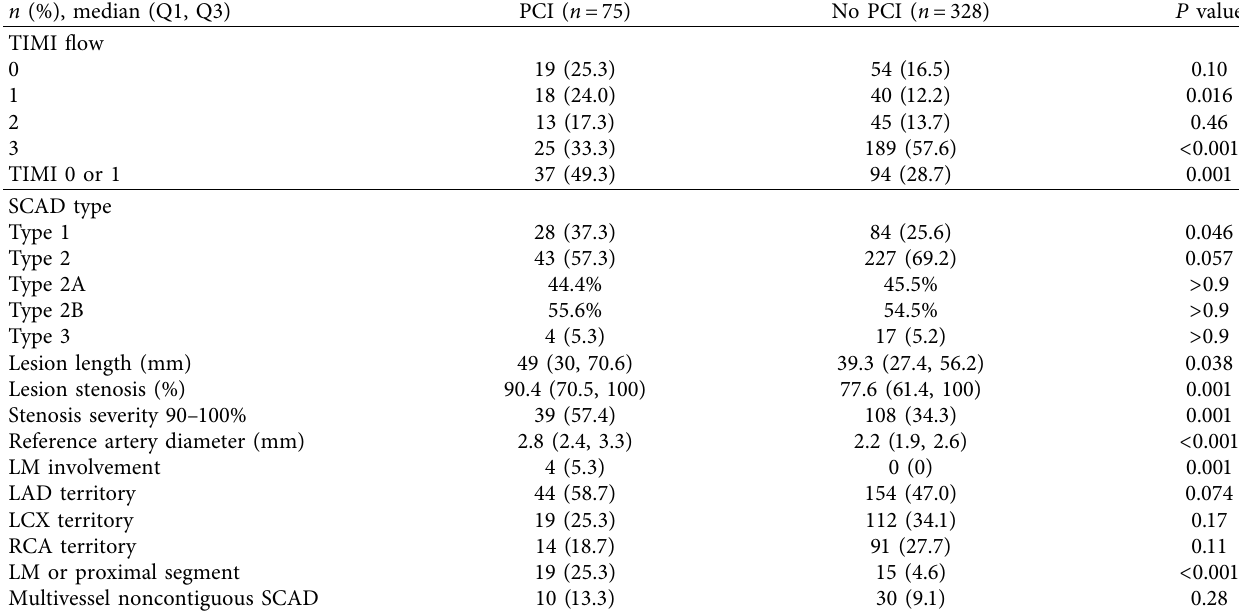
Table 2: Angiographic characteristics.